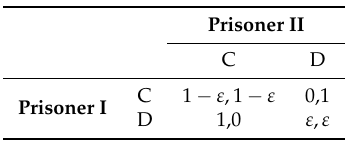
Table 7. A variant of the prisoner’s